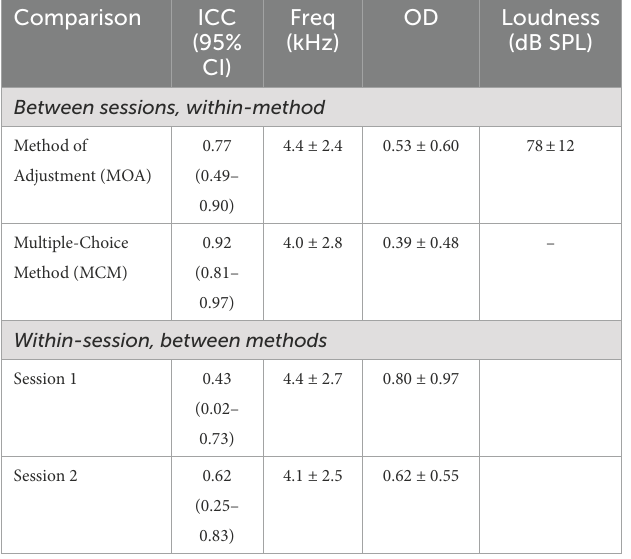
TABLE 2 Averaged pitch matching results and reliability measures. Comparison